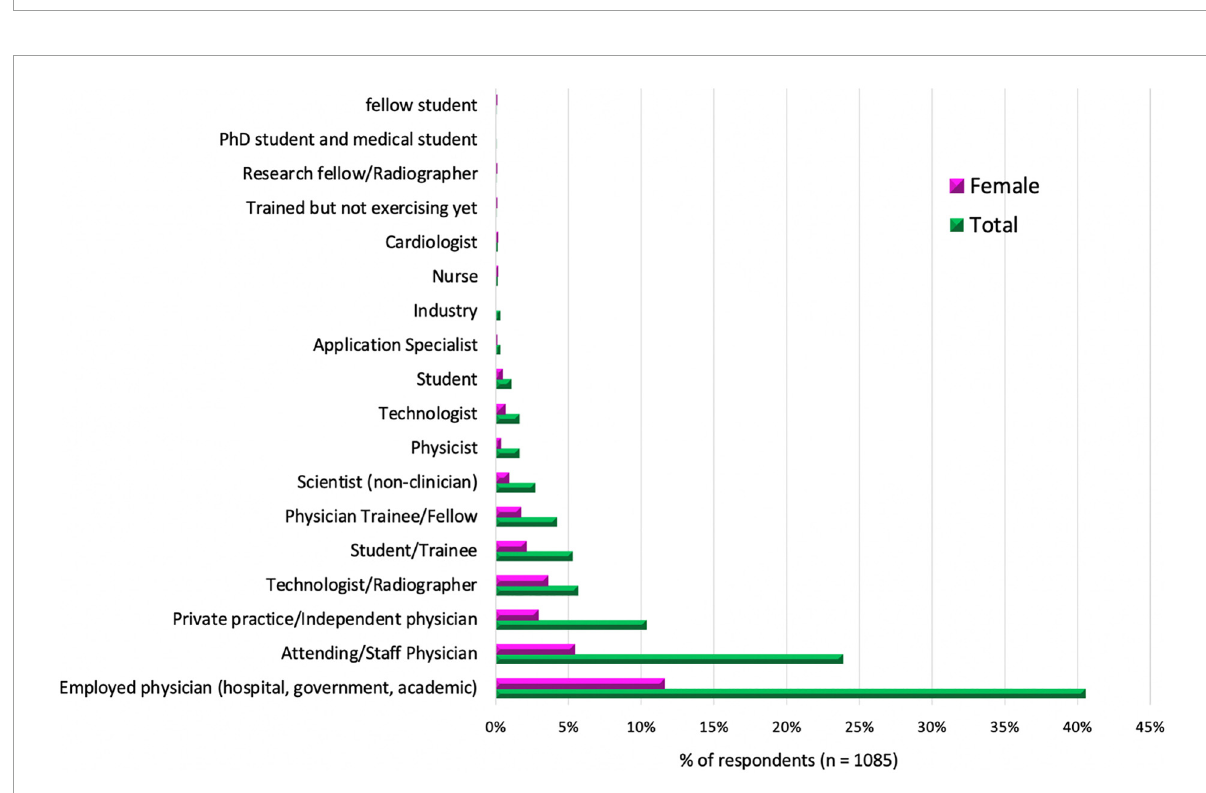
FIGURE4 Stage of training or primary practice type of the CMR survey practitioners. This bar graph shows the different types of primary practice or stages of training of those CMR surveyed practitioners. The distribution is shown in percentages of total (male and female) in green and just female respondents in